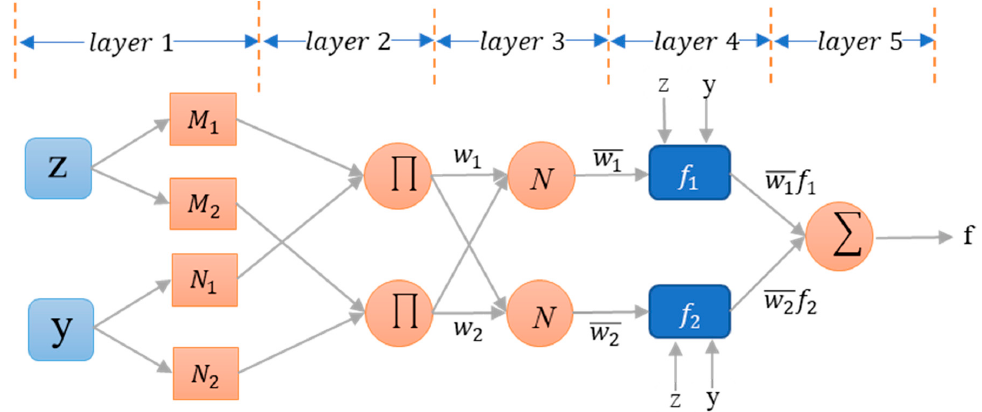
Figure 4. The ANFIS architecture with two inputs (z, y), two rules, and one output (f).